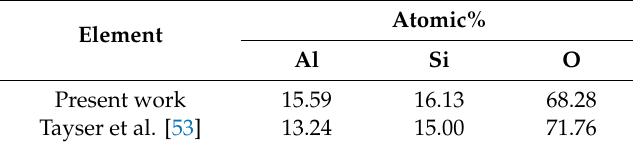
Table 2. Energy-dispersive X-ray (EDX) analysis results of